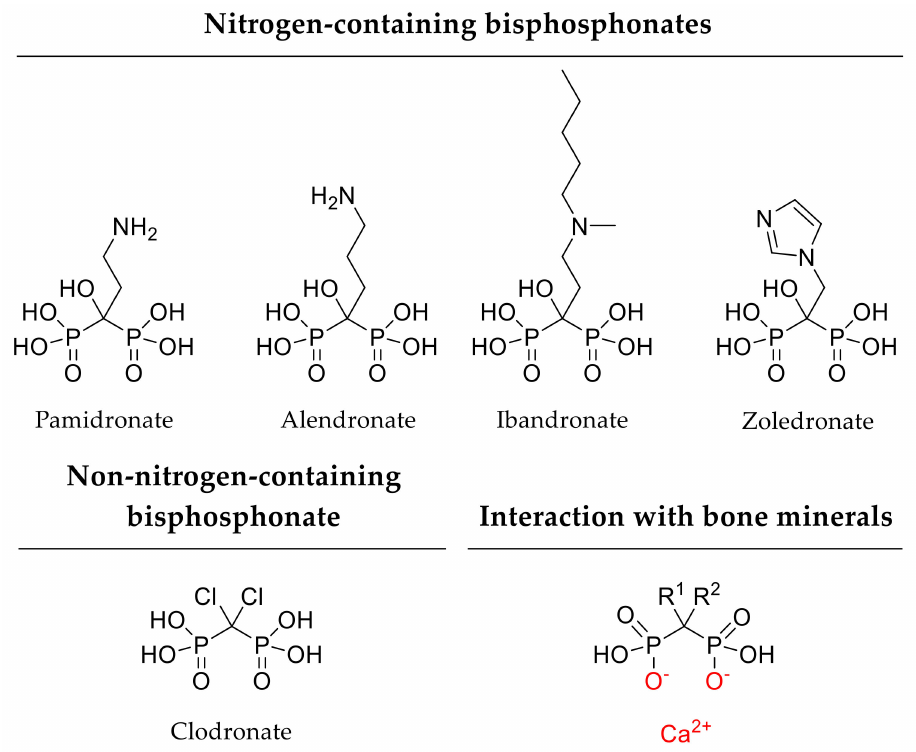
Figure 2. Chemical structures of selected anti-resorptive bisphosphonates. Bisphosphonates improve the bone quality due to accelerated bone mineralization and are frequently used in the treatment of osteoporosis. The hydrophilic molecules contain the typical P–C–P core structure and exhibit a high binding a ffi nity to bone